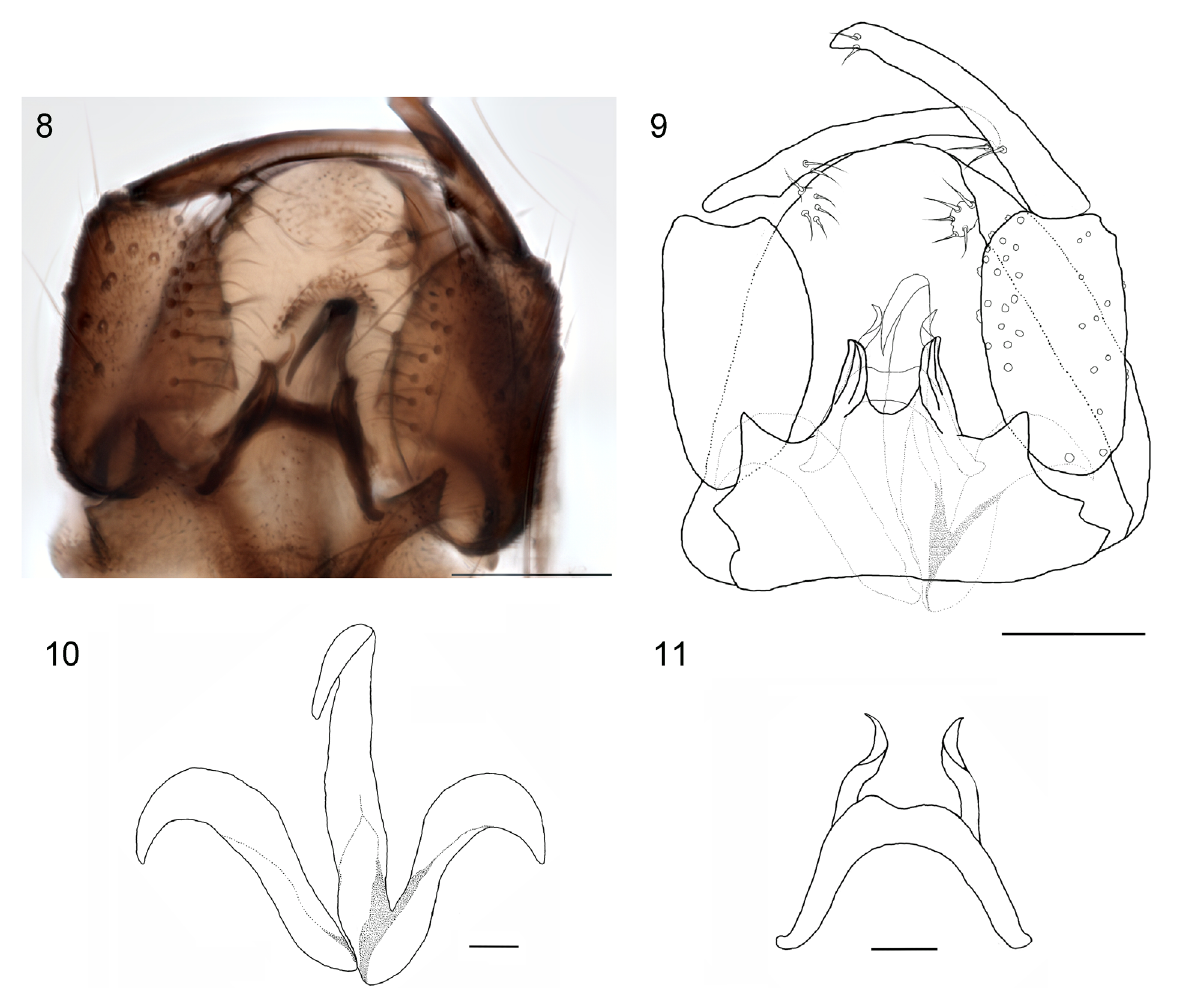
Figs 8–11. Dasyhelea dominiakae sp. nov., holotype, ♂. 8–9 . Ventral aspect of genitalia. 10 . Parameres. 11 . Aedeagus. Scale bars: 8–9 = 50 µm; 10–11 = 16